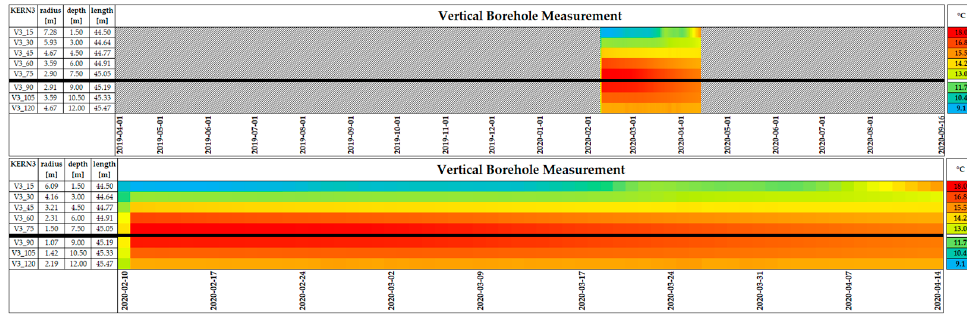
Figure 23. KERN3 vertical borehole temperature profile.